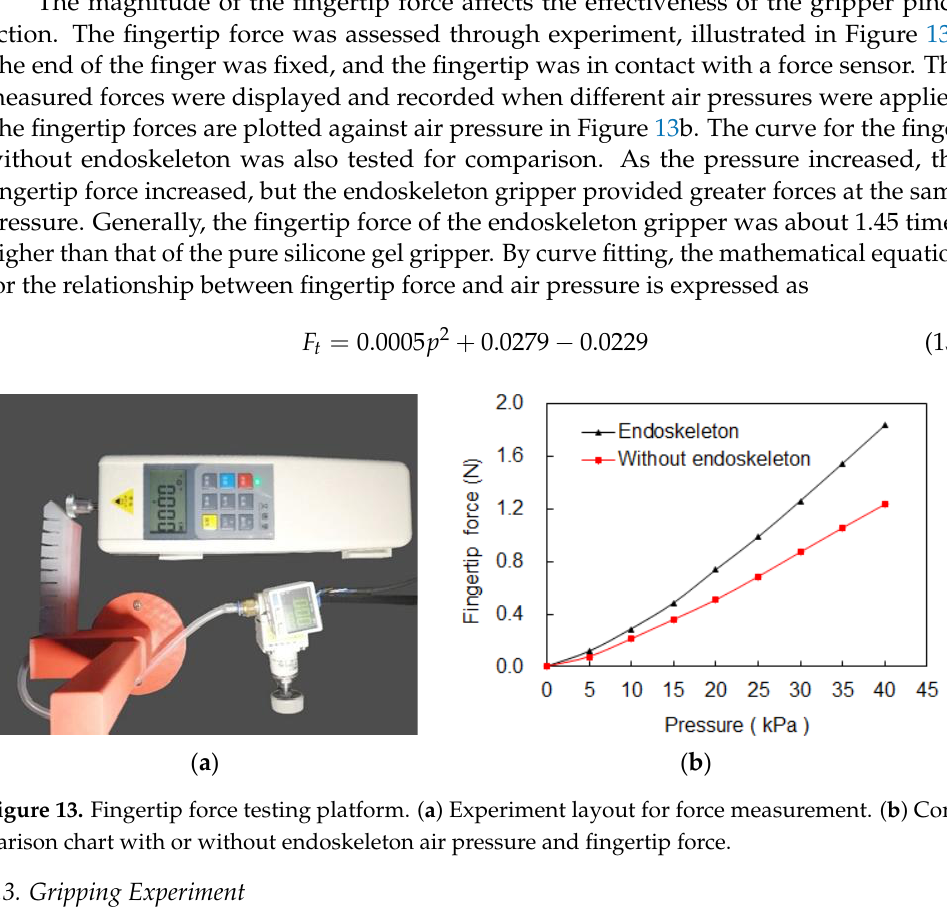
Figure 12. Fingertip contact diagram under air pressure 30 kPa.